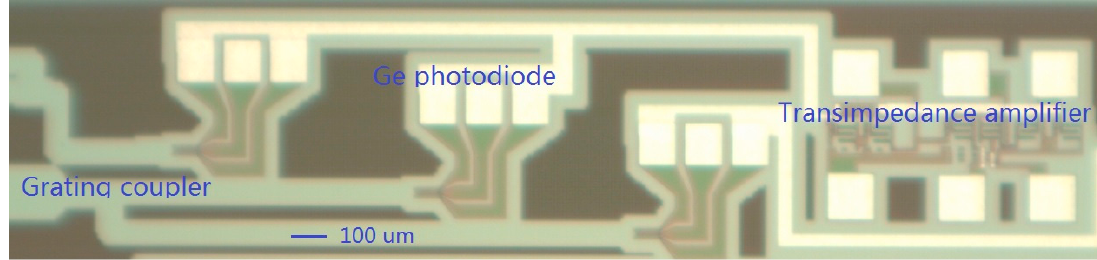
Figure 6. Microscopic view of the integrated optoelectronic circuit, showing the grating couplers, Ge photodiodes, and transimpedance amplifier fabricated by the IME process.